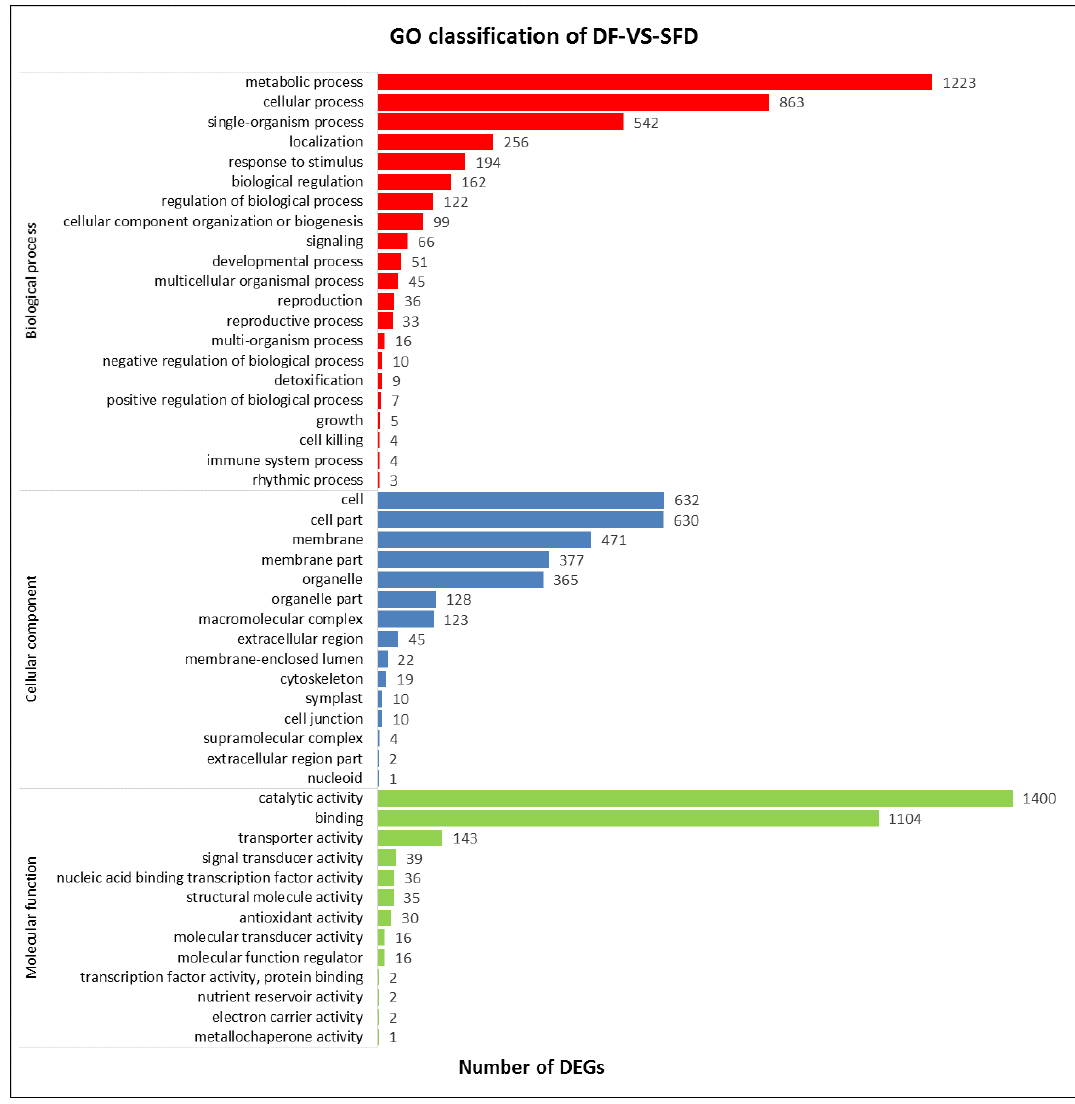
Figure 4. Gene ontology analysis between single and double flower varieties showing abundance of differentially expressed GO-terms.